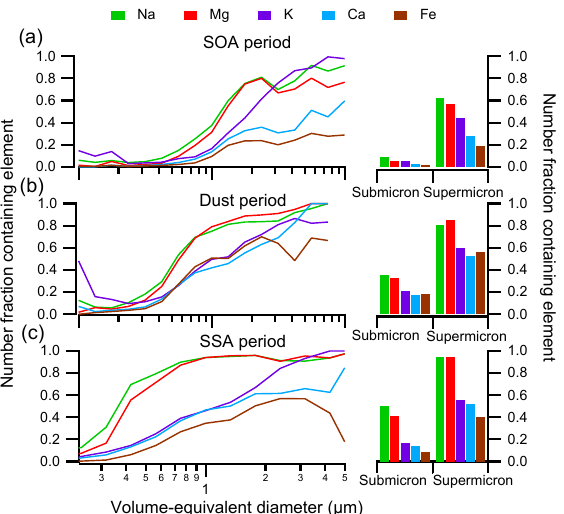
Figure 6. (Left) Size-resolved compositions indicate the number fraction of particles containing nonvolatile cations Na, Mg, K, Ca, and Fe during the (a) SOA period, (b) dust period, and (c) SSA period. (Right) The number fraction of submicron and supermicron particles during each period containing each nonvolatile cation.